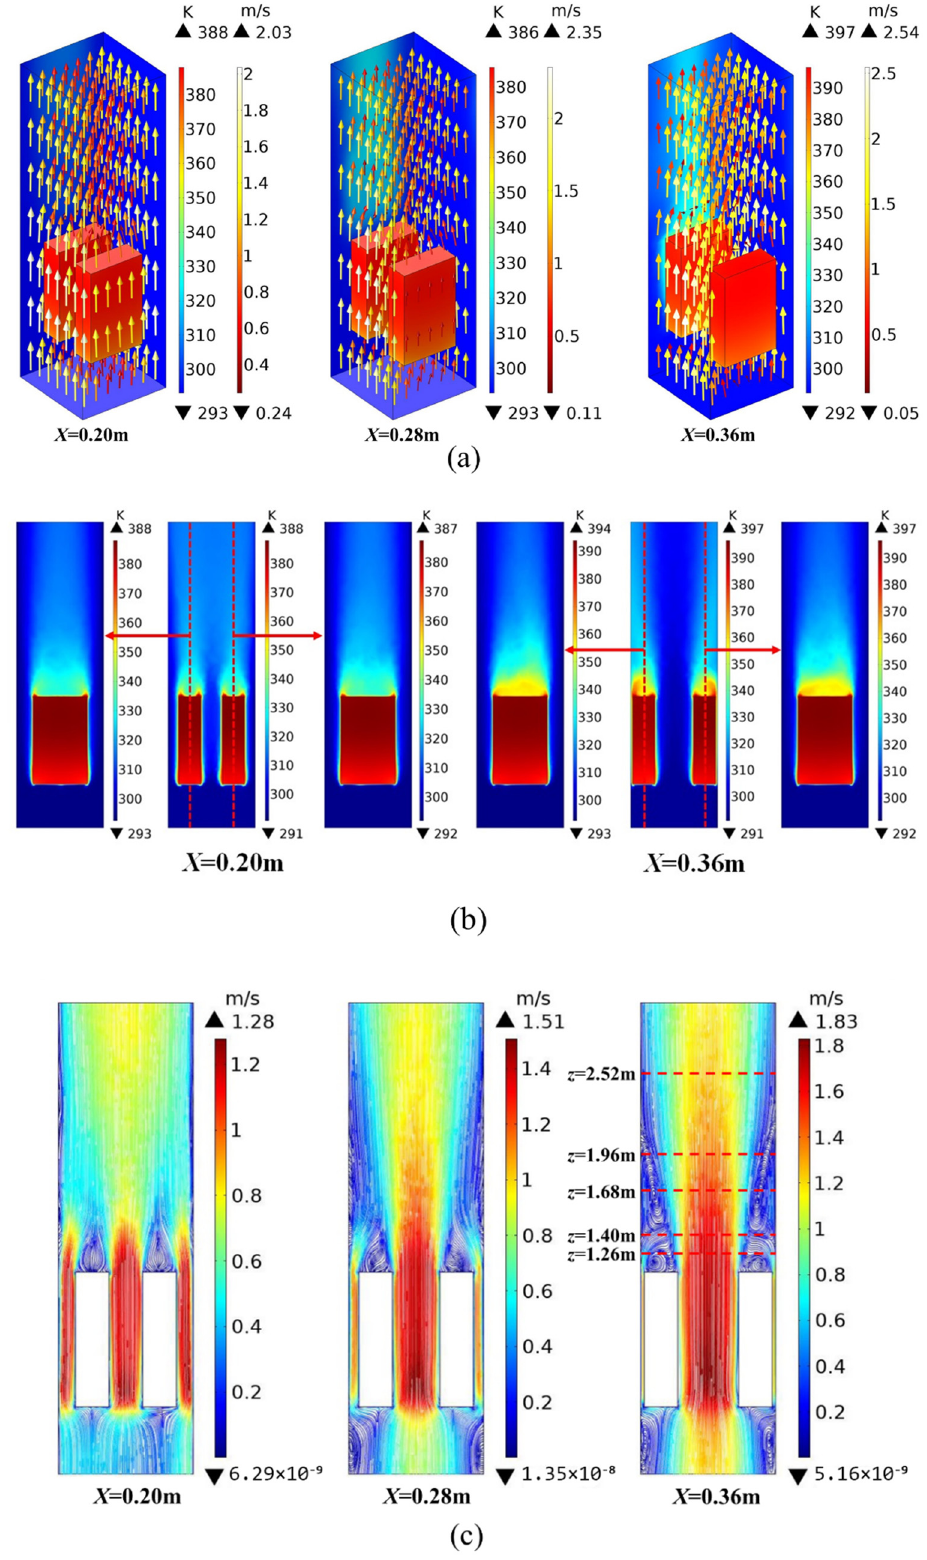
Figure 3. Temperature and velocity distributions in the open-ended square channel with different horizontal distance X at L = 0. ( a ) Temperature and velocity vector distributions. ( b ) Temperature distribution of the central cross section of both and each heat sources. ( c ) Velocity distribution in the z direction on the cross section where y = W/2.